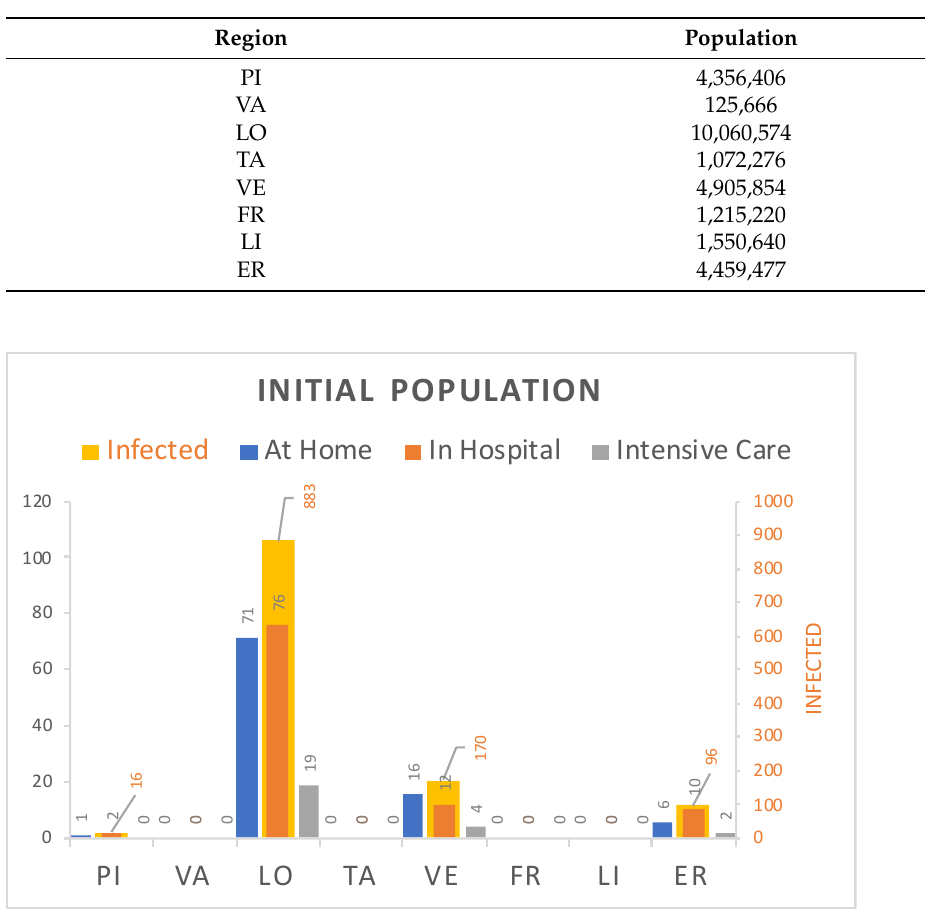
Table 2. Regions population. Reproduced from www.istat.it .